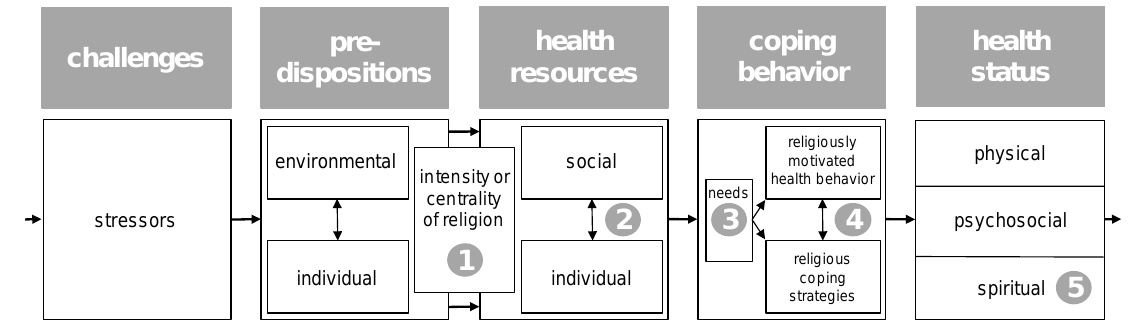
Figure 1. Vulnerability-stress-model, integrating various aspects of religiosity/spirituality along a path between stressors and health (adapted in a modified version from [30,31]). The numbers one to five denote the components for which specific questionnaires of reli- giosity/spirituality exist (see section